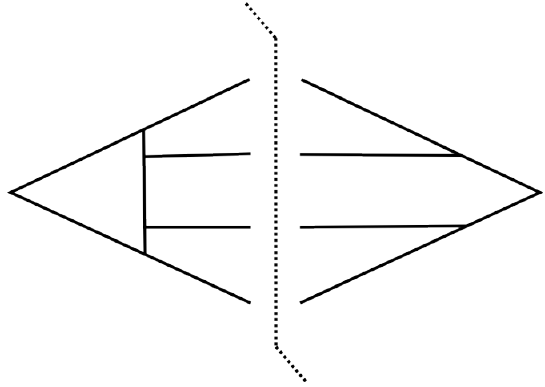
Figure 3 . One-loop virtual correction to double soft current contributing to the cross-section at three